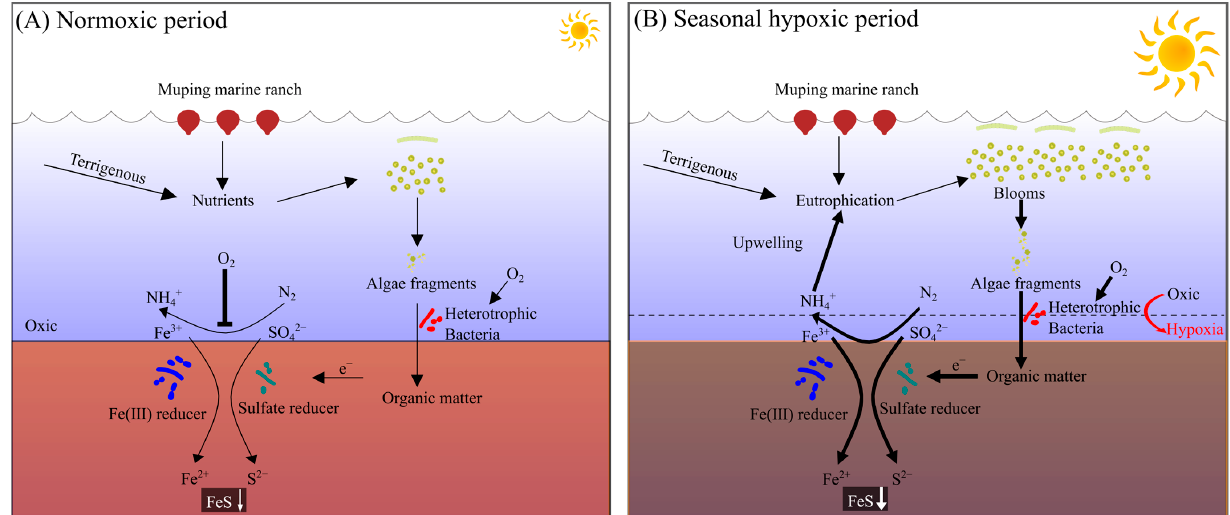
Figure 8. The patterns of benthic nitrogen fixation under ( a ) normoxic and ( b ) seasonal hypoxic conditions in Muping Marine Ranch. The thick arrows indicate higher fluxes and the symbol ( ⊥ ) represents inhibition.